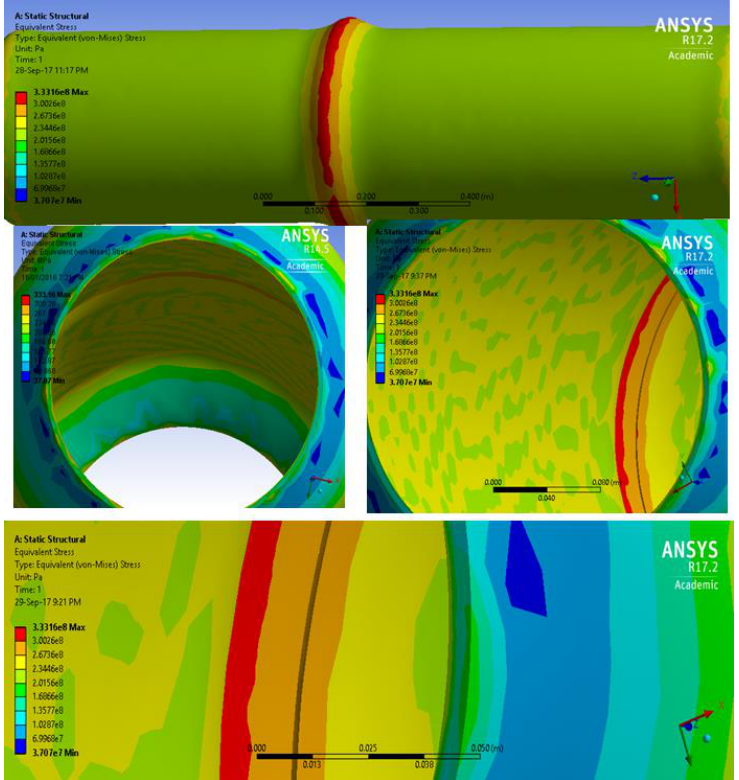
Figure 6. Stress distribution around the corrosion defect section and the non-corroded sections of the X46 grade pipe with 273.05 mm diameter, 5.23 mm thick, d/t of 0.1 and L of 105 mm.